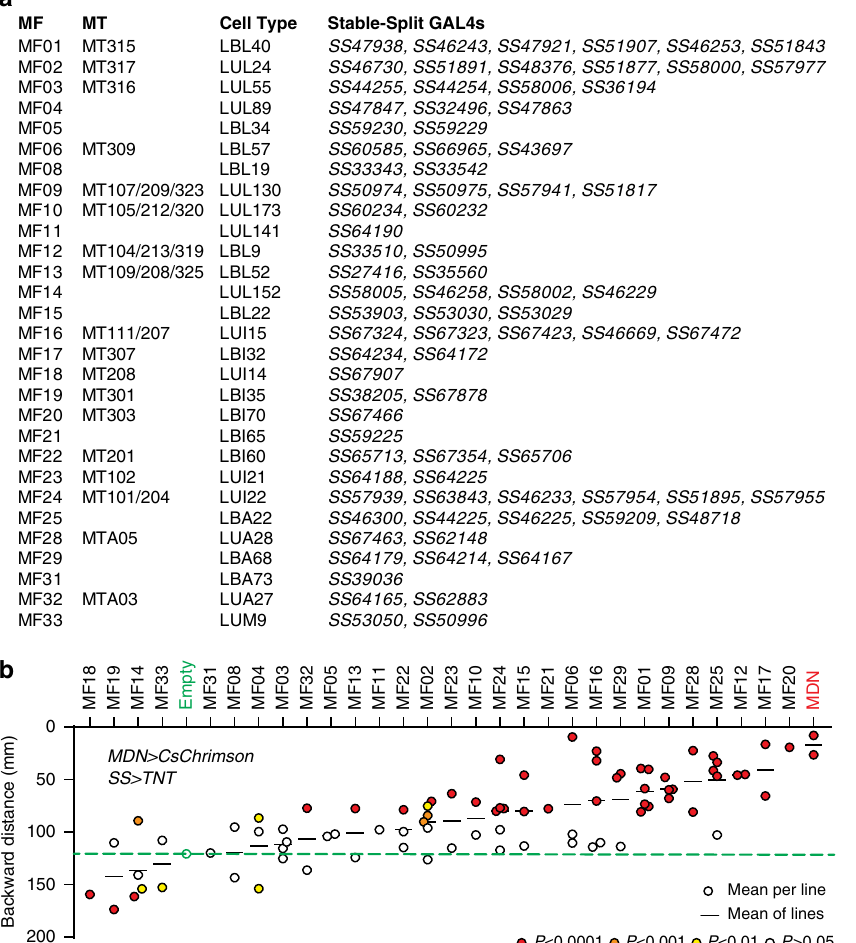
LBL40 neurons trigger tibia fl exion via the tibia-reductor motor neurons . The LBL40 cells, identi fi ed in both the MDN trans-Tango (MT315, Fig. 2c) and functional imaging experi- ments (MF01, Fig. 3d and Supplementary Movie 5), are a bilateral pair of neurons speci fi c to the T3 neuropils (Fig. 5a). They resemble the only surviving neurons of the 14B lineage 29 . Each of